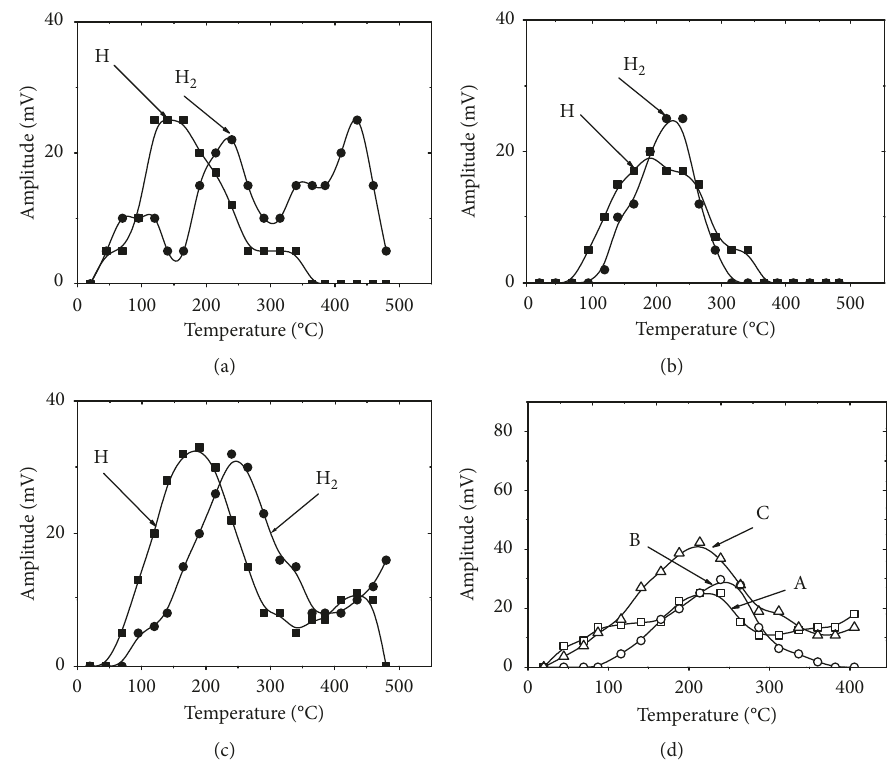
Figure 3: Mass spectrometric data on temperature dependences of atomic and molecular hydrogen desorption from the nc-SiC films of the A (a), B (b), and C (c) types and integral hydrogen desorption from nc-SiC A, B, and C films versus temperature